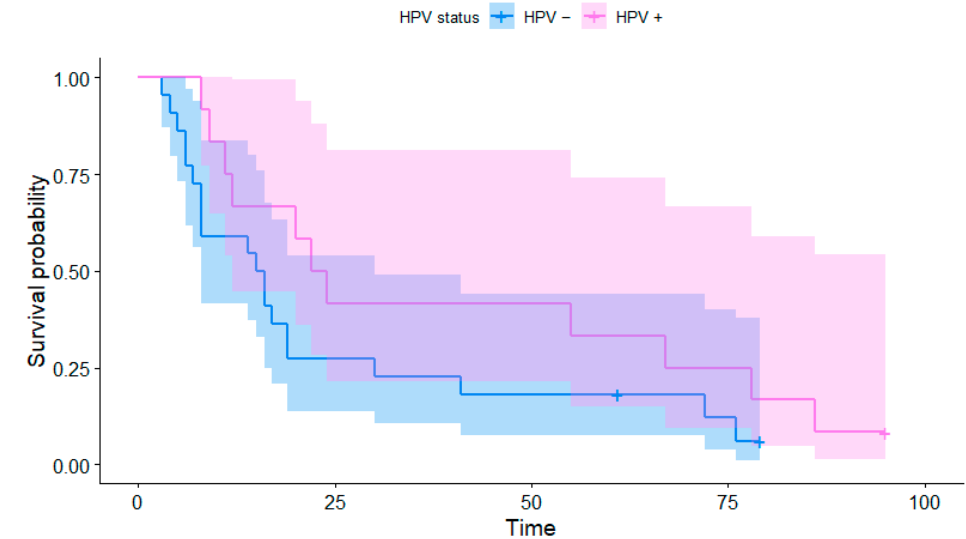
Figure 1. Kaplan–Meier curves of the overall survival depending on the HPV status.